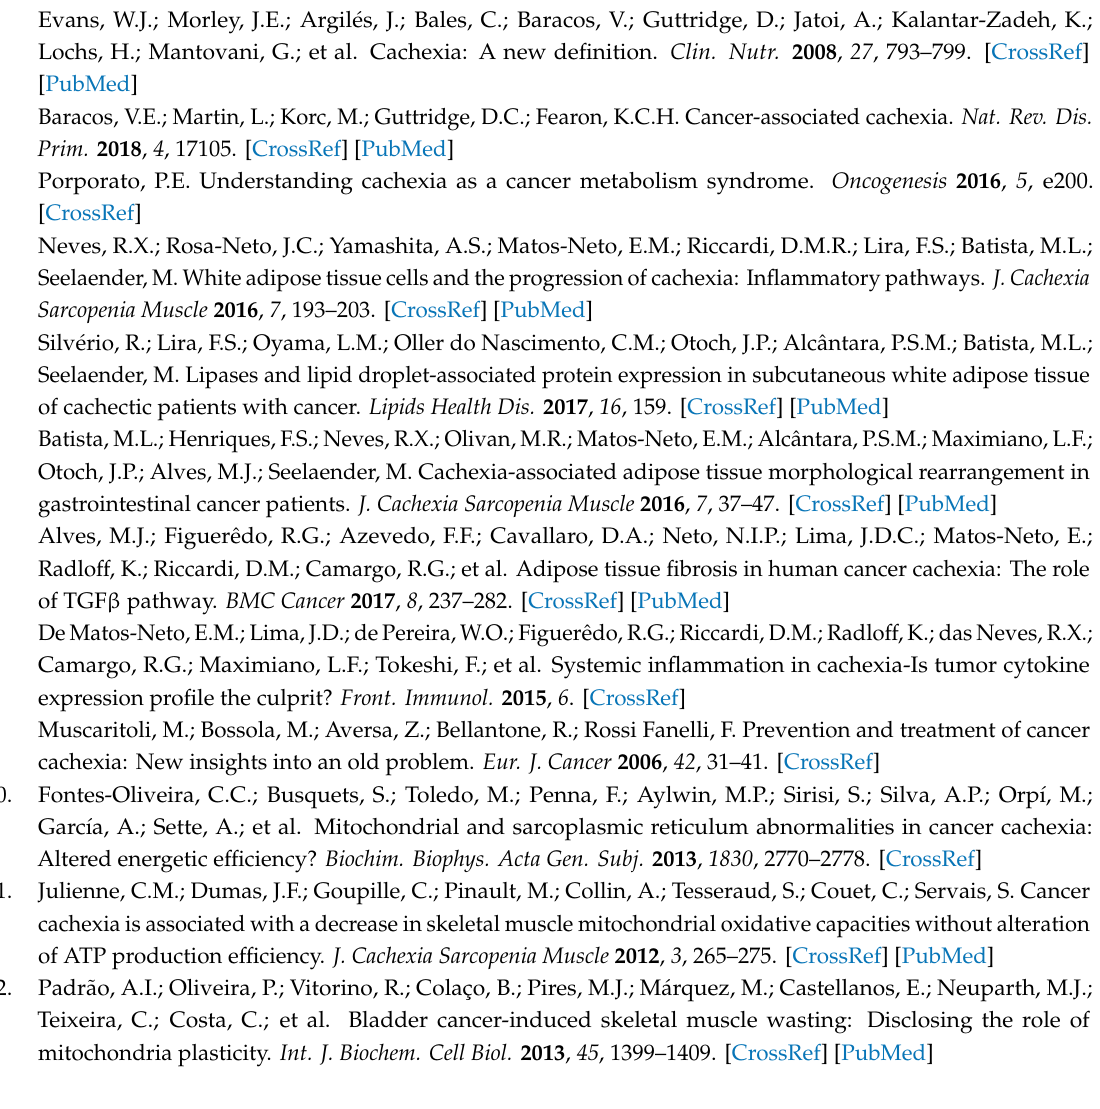
Figure S1: Higher magnification of skeletal muscle photomicrograph showing intermyofibrillar mitochondria of WSC and CC, Figure S2. Skeletal muscle nuclei photomicrograph of WSC ( n = 3) and CC ( n = 4). Black arrows indicate apoptotic body; white arrow indicate chromatin condensation in CC patients. WSC—weight-stable cancer patients; CC—cachectic cancer patients, Table S1: Analyses performed in each patient of the Weight–Stable